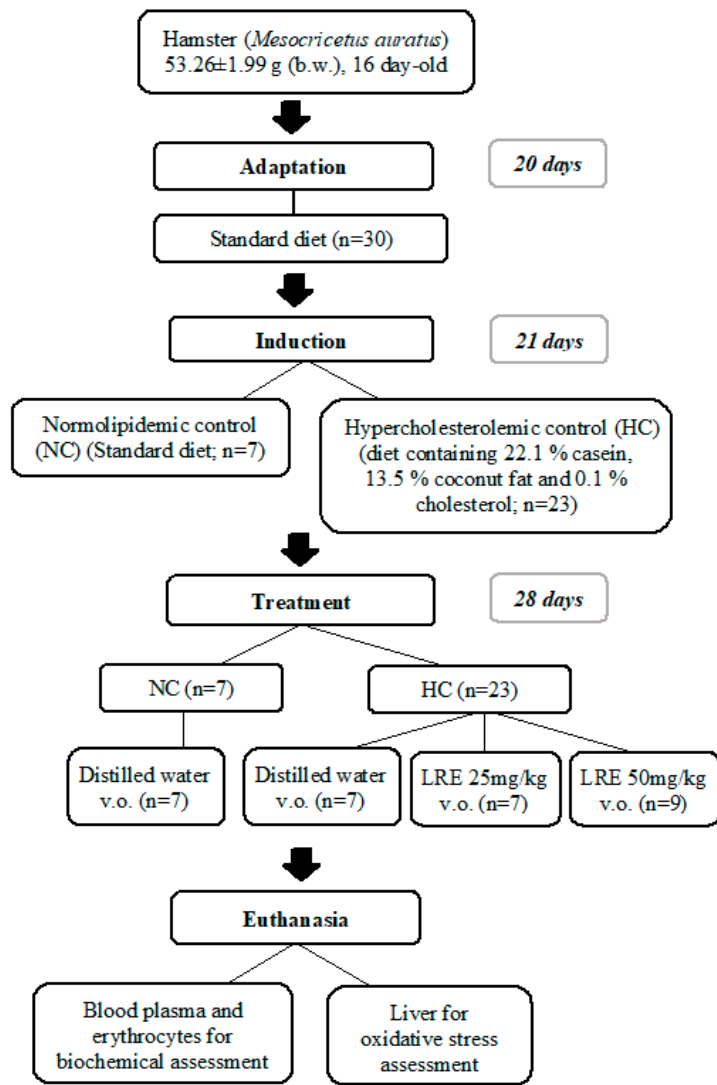
Figure 1. Scheme of experimental protocol of dyslipidemia induction and treatment with lycopene-rich extract (LRE) in hamsters.